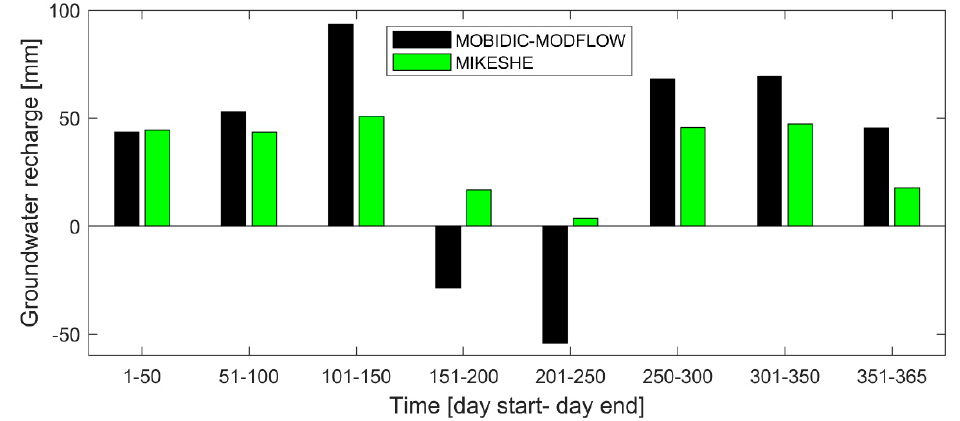
Figure 12. Catchment scale behavior of the groundwater recharge simulated by MIKE SHE (green) and MOBIDIC-MODFLOW (black).